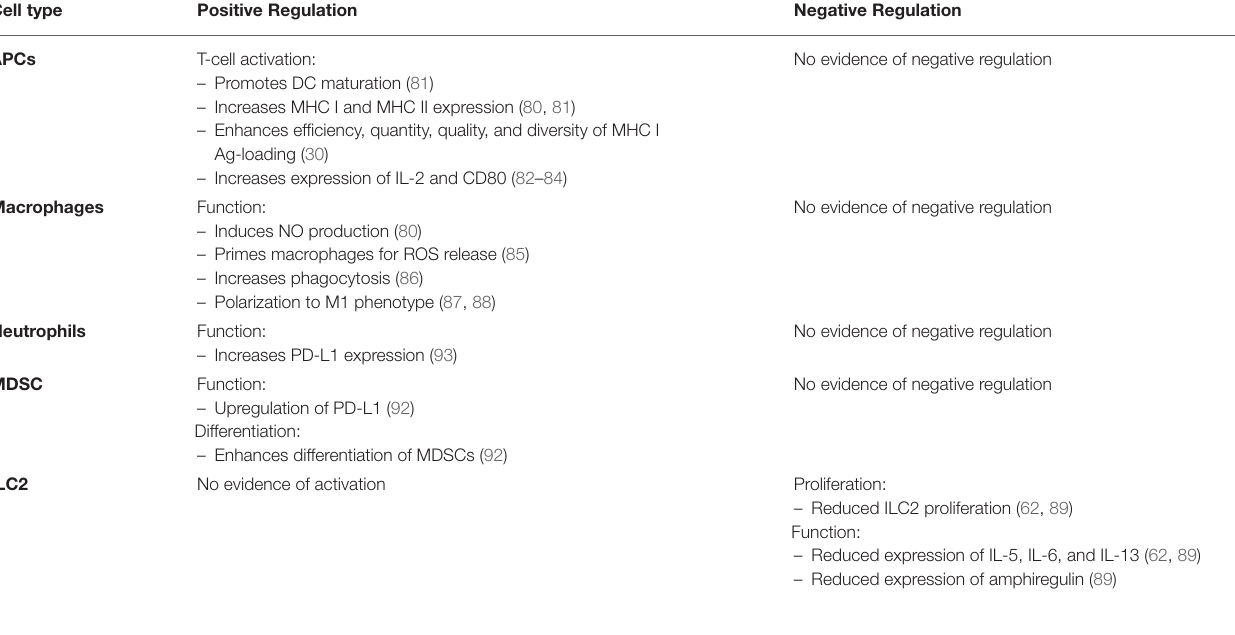
TABLE 2 | The role of IFN- γ in regulating the antiviral innate immune response. Cell